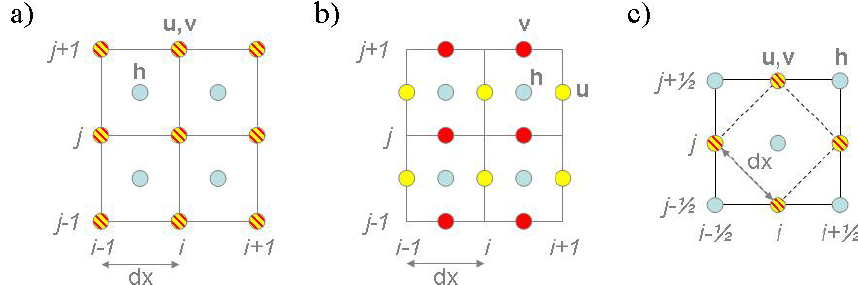
Fig. 2. Graphical illustration of grid cells in an X-Y plane and the placement of the scalars (“ h ”, shown in light blue) and the u- and v- components of the wind (“ u ” and “ v ”, shown in yellow and red, respectively) on the (a) Arakawa B, (b) Arakawa C and (c) Arakawa E grids (based on Arakawa and Lamb,